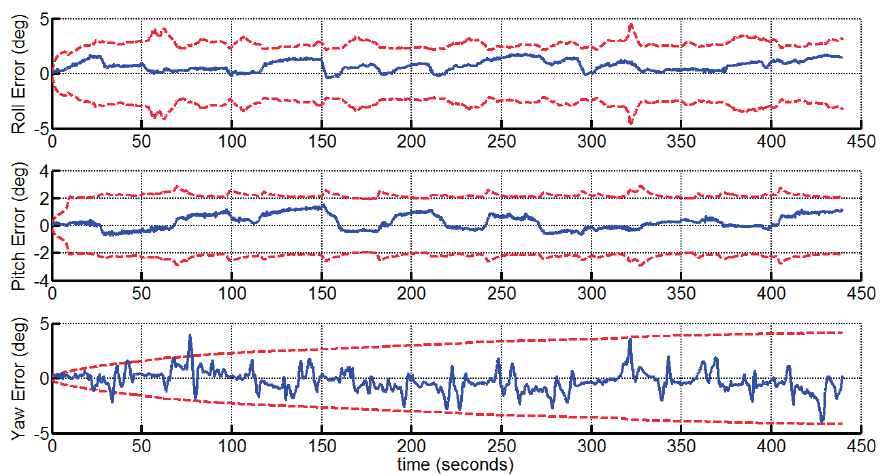
Figure 6. The attitude estimation errors and 3 σ bounds.